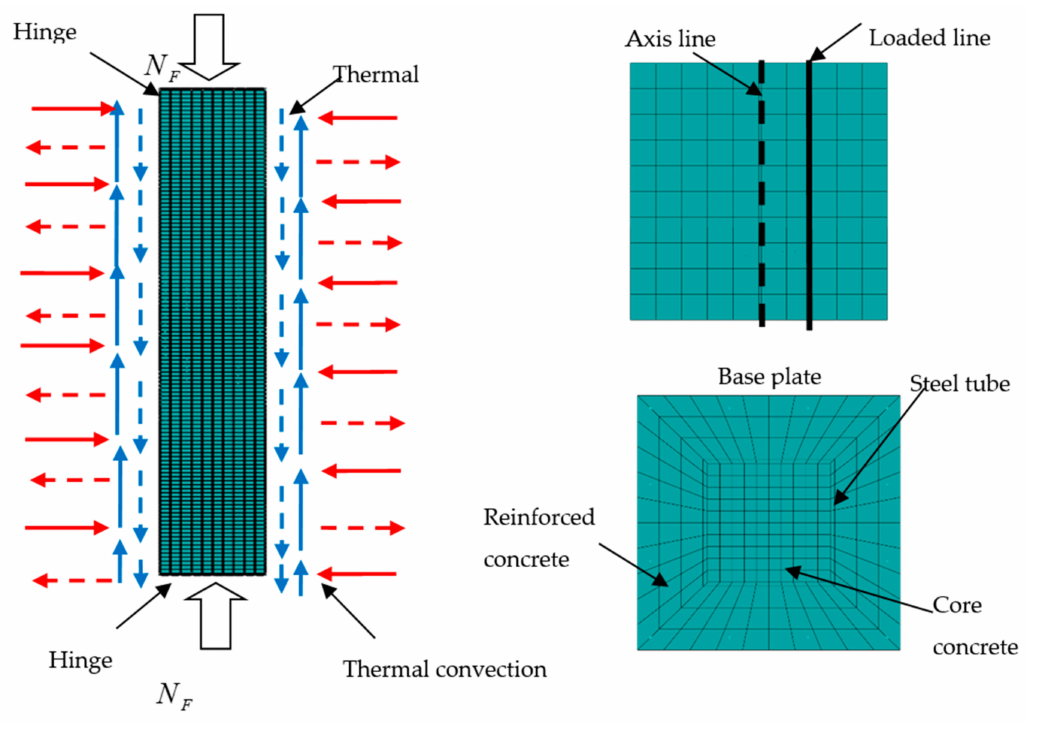
Figure 2. FE model of the square-cased square ST-RC columns.